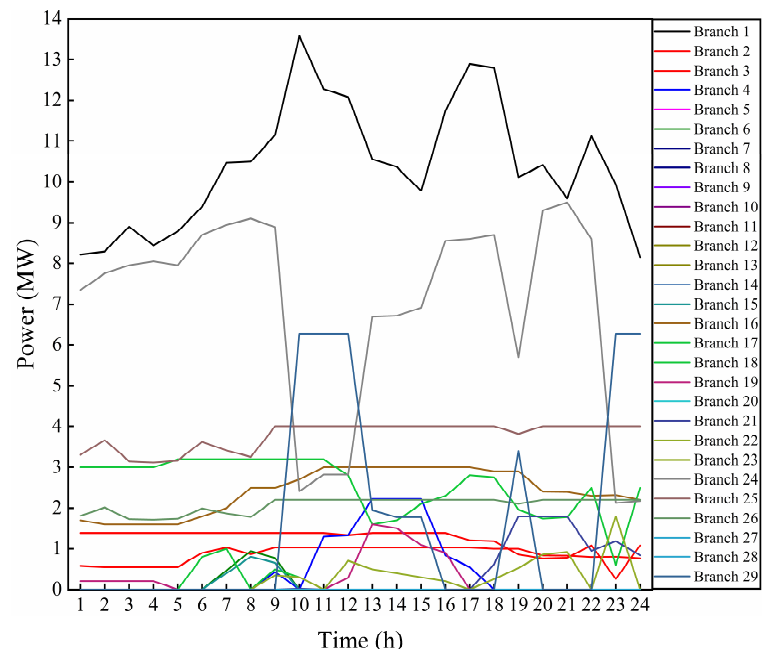
Figure 6. Energy flow of PIES 1 in scenario 4.